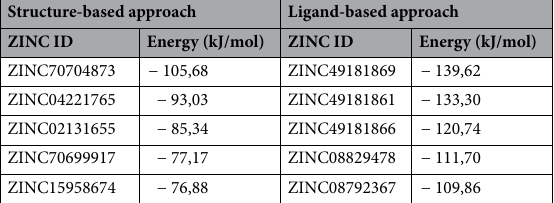
Structure-based